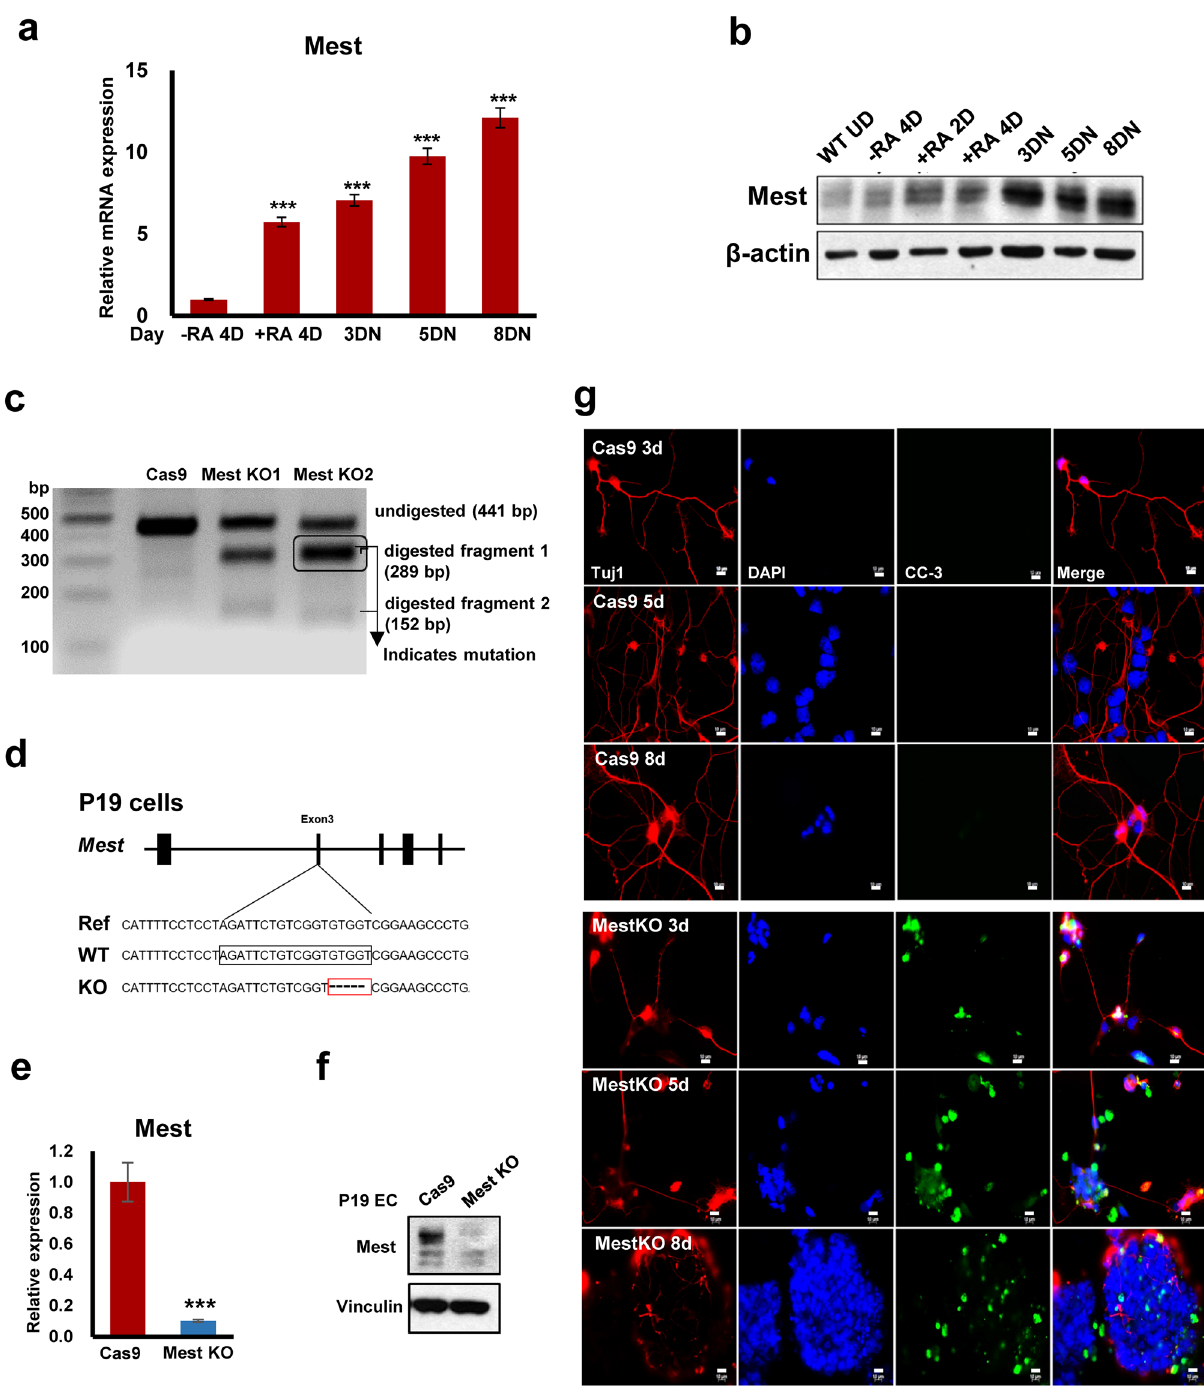
Figure 2. Mest knockout in P19 embryonic carcinoma leads to neuron differentiation blockade. ( a ) qPCR analyses of Mest mRNA expression during neuronal differentiation. Total RNA was isolated at the indicated time points. ( b ) Mest protein levels in retinoic acid induced-P19 neuronal differentiation. ( c ) T7E1 assay for P19 Mest knockout (KO) cells. PCR products were generated from the genomic DNA of P19 Mest KO cells. The PCR products were annealed & digested with T7 Endonuclease I. Fragments were analyzed to determine the efficiency of genome targeting. ( d ) Sanger sequencing of the P19 Mest KO cells showed a 5-base pair deletion near the gRNA target site. The black box indicates the Mest gRNA target region. ( e ) qPCR analyses of Mest mRNA expression in P19 Mest KO cells. ( f ) Mest protein levels in P19 Cas9 and Mest KO cells. ( g ) Mest KO caused neuron differentiation blockade in P19 cells. P19 differentiated neurons were fixed and immunostained with anti-Tuj1 (red) and cleaved caspase-3 ((CC-3), (green)) antibodies at the indicated times. Scale bars, 10 μm. mRNA levels were normalized to that of β-actin. Data are shown as mean ± SD; ***, p < 0.001, compared with the corresponding control group. Student’s t test was used for statistical